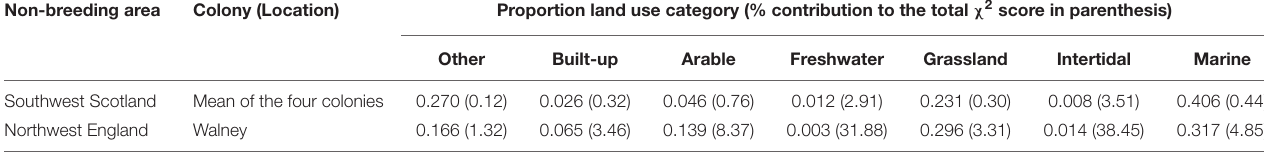
TABLE 2 | Composition of available habitat at the landscape scale within migration range of each herring gull colony in southwest Scotland (combined Southern Hebrides and Firth of Clyde) and in northwest England (Walney). Non-breeding area